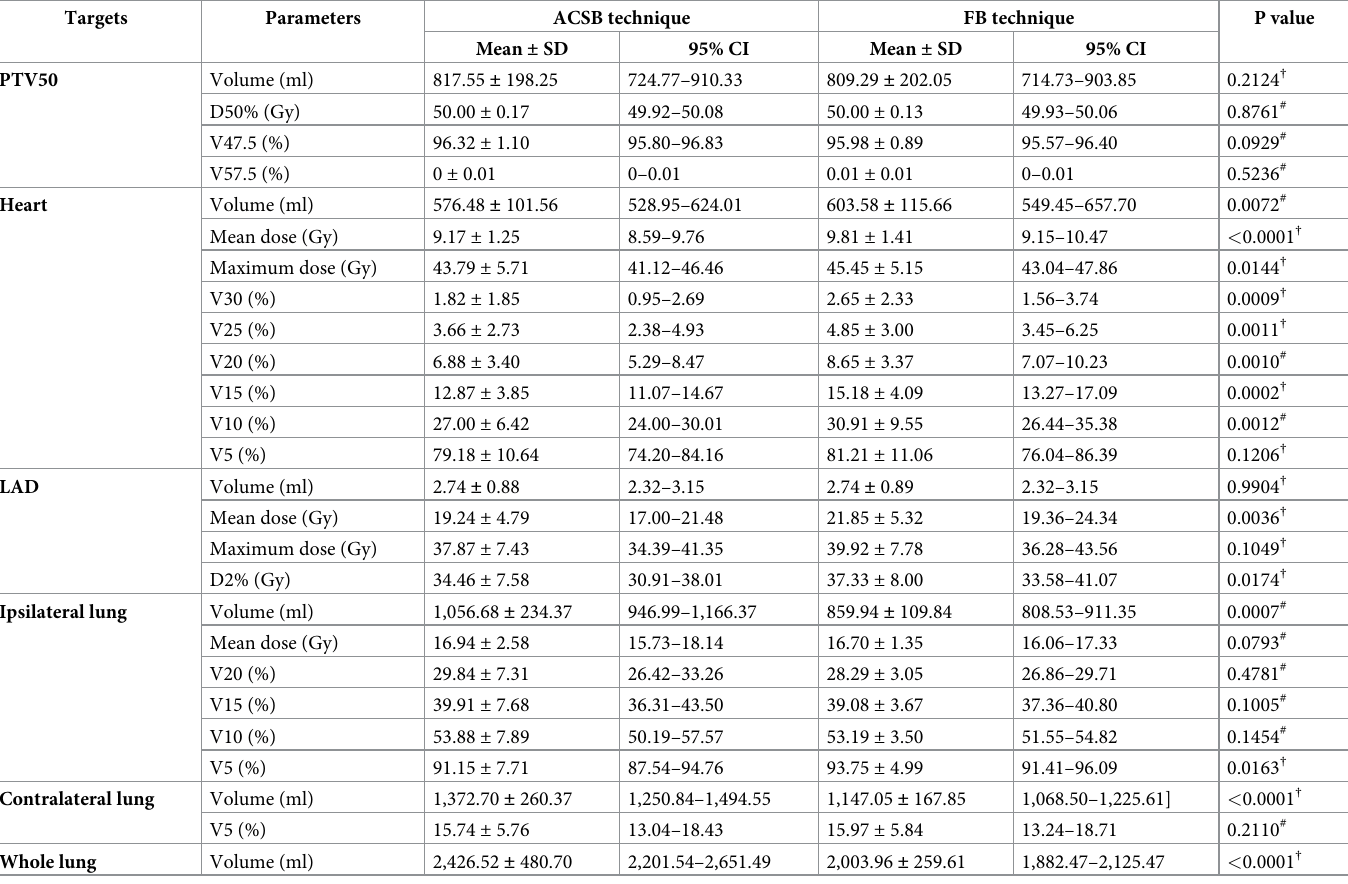
Table 2. Mean values of DVH parameters for heart, LAD, lungs and PTV for patients treated between two techniques.